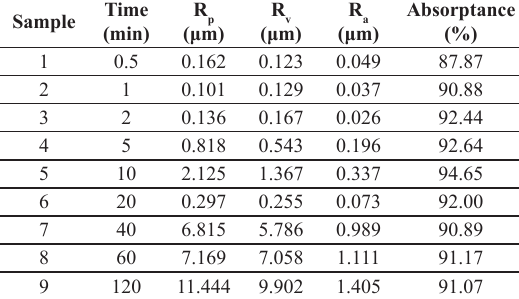
Figure 4. Diffractograms of the produced films. Table 3. Roughness parameters.